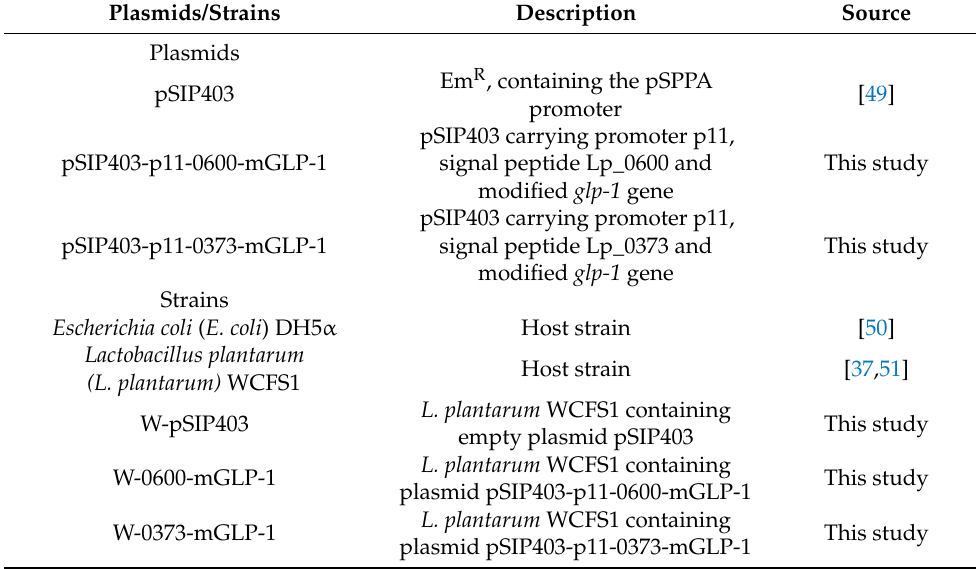
Table 1. Plasmids and bacterial strains used in this